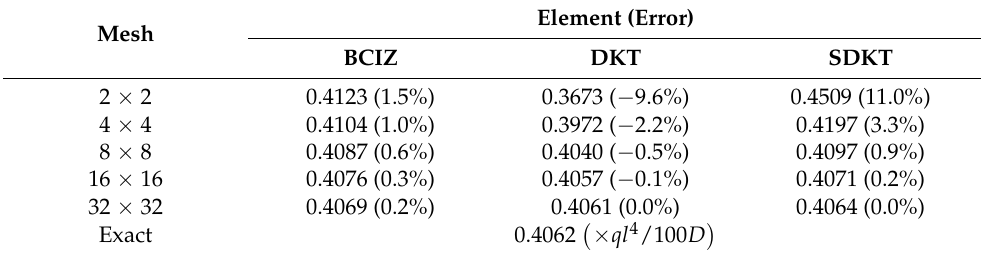
Figure 5. Central deflection for a square plate under uniform load using SDKT element: ( a ) Simply supported; ( b ) clamped.